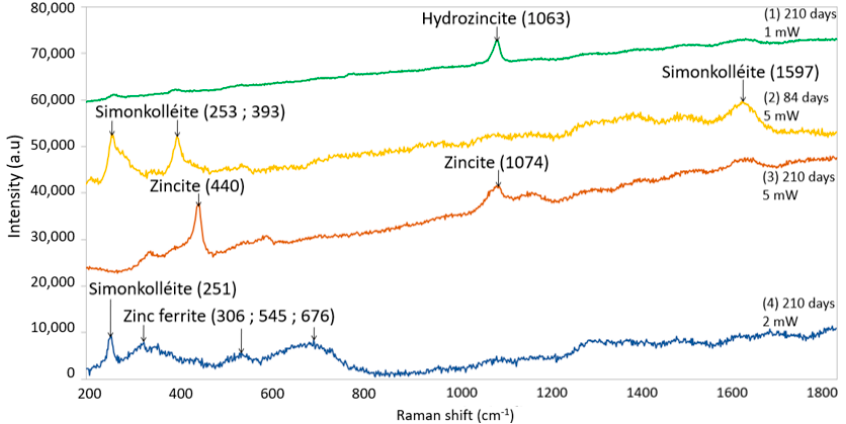
Figure 13. Four examples of Raman spectroscopy analysis of a corroded steel wire surface.